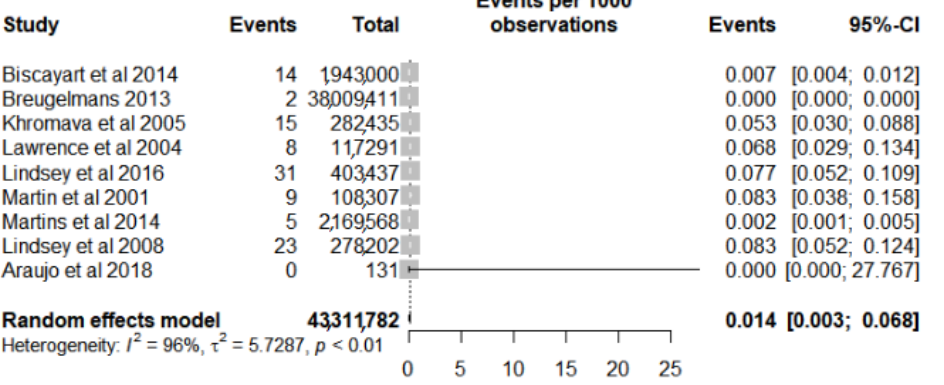
Figure 2. Forest plot of prevalence meta-analysis for serious adverse events after yellow fever vaccine use in the elderly after outlier study removal.